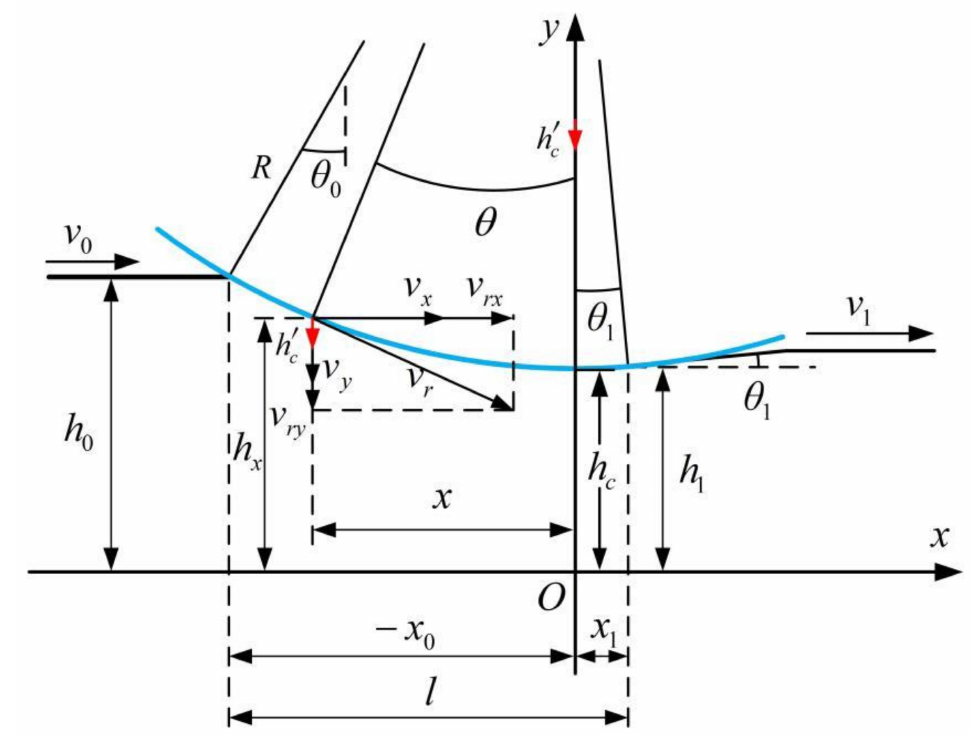
Figure 6. Dynamic rolling deformation